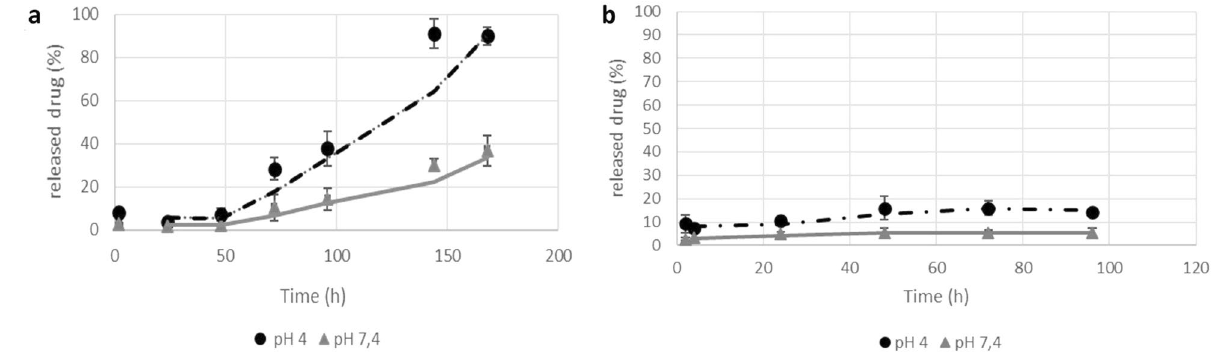
Figure 2. In vitro release kinetics of fluopyram ( a ) and pterostilbene ( b ) from PLGA NPs at 25 °C and different pH